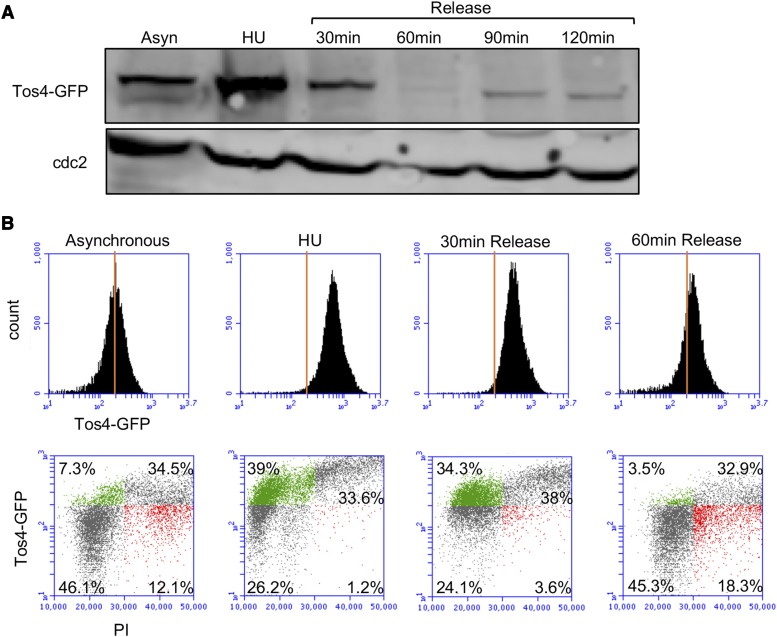
Tos4 protein level is increased in S phase cells arrested by HU. (A) WT cells with Tos4-GFP in asynchronous culture, after treatment with 12 mM HU, or after release from HU were lysed and immunoblotted for GFP and cdc2 (loading control). (B) WT cells used in (A) were fixed in 70% ethanol, and FACS analyzed for GFP and propidium iodide (PI). Green in scatter plot represents population with high GFP and low PI while red represents population with low GFP and high PI.